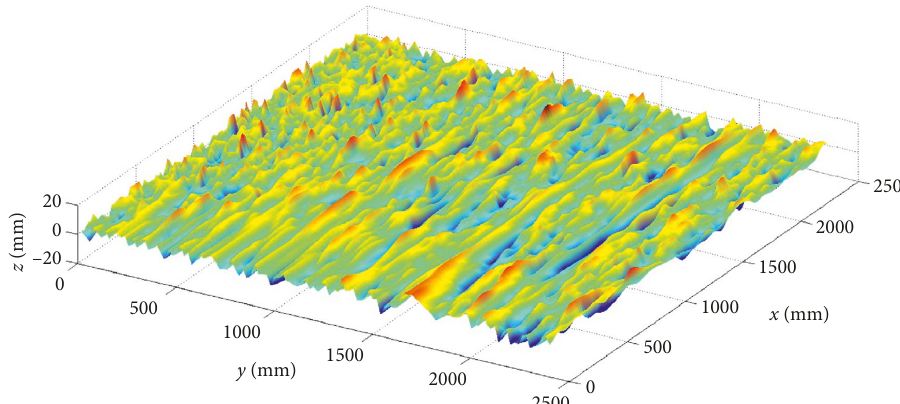
Figure 3: Fractal surface model for D